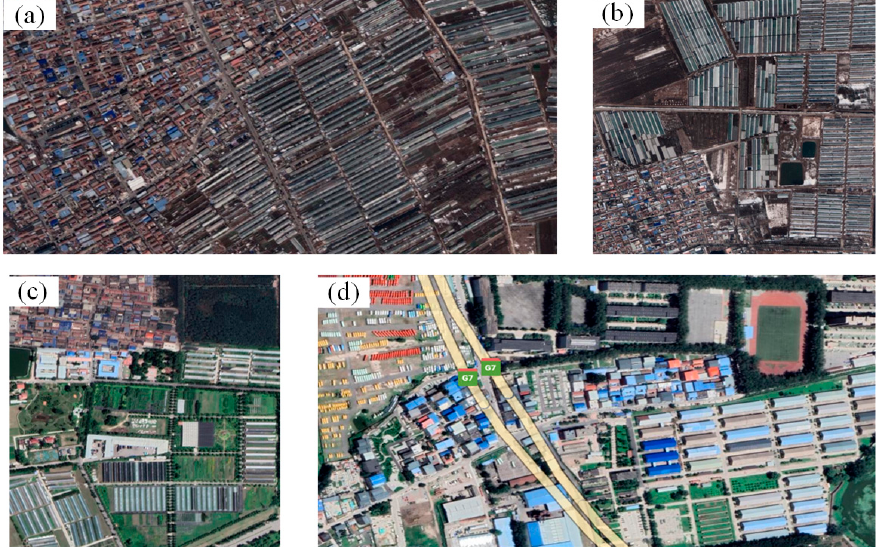
Figure 14. The topography of four depression funnels in Google Earth. ( a ), ( b ), ( c ) and ( d ) shows the topography of A, B, C, and D, respectively. The location of A, B, C, and D can be found in Figure